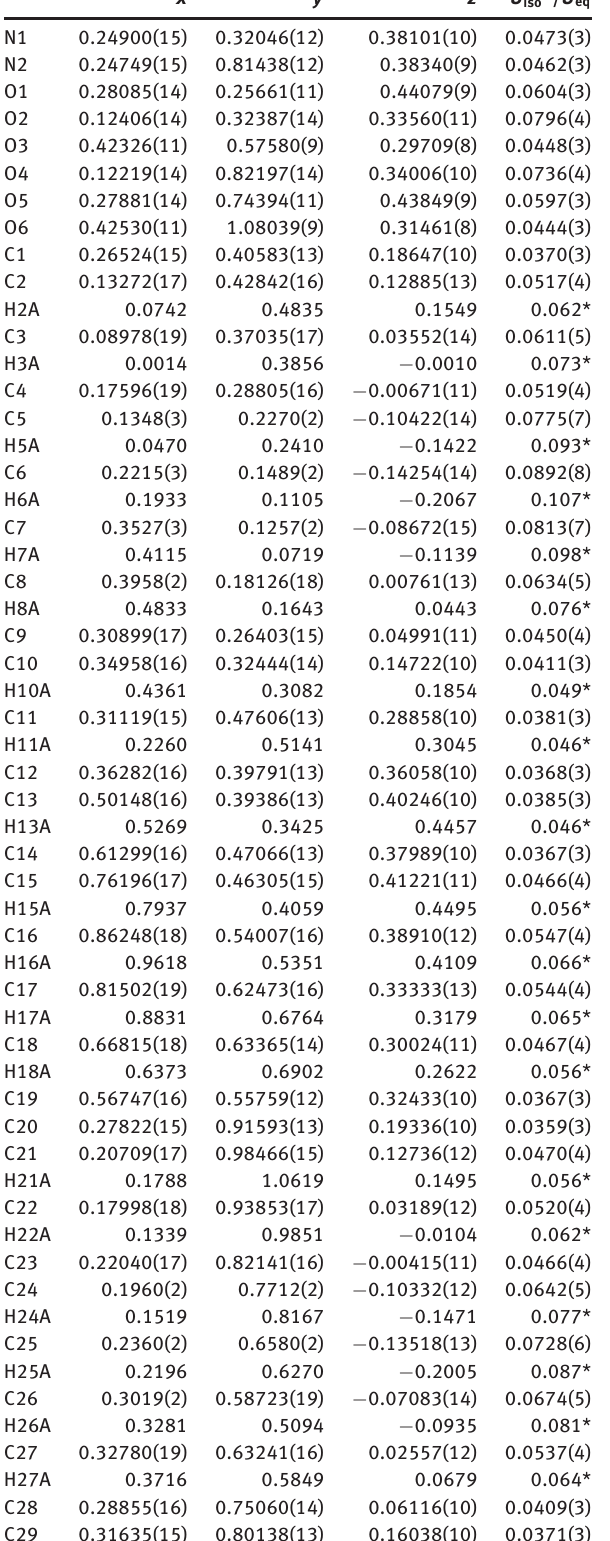
Table 2: Fractional atomic coordinates and isotropic or equivalent isotropic displacement parameters (Å 2 ).